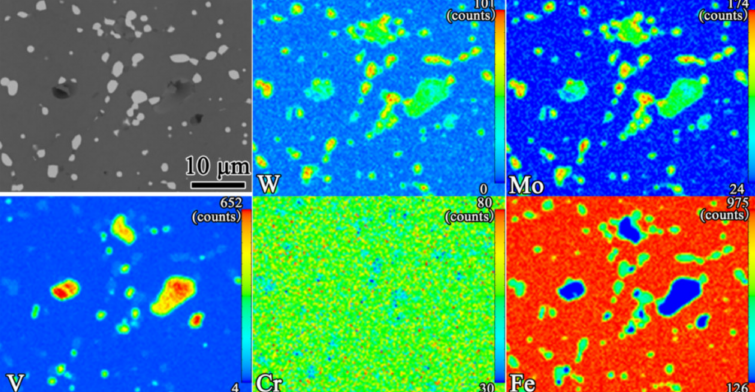
Figure 8. The EPMA mapping results for the quenching of samples at 1200 ◦ C. The values in the top-right corner of each figure indicate the maximum concentration (red).